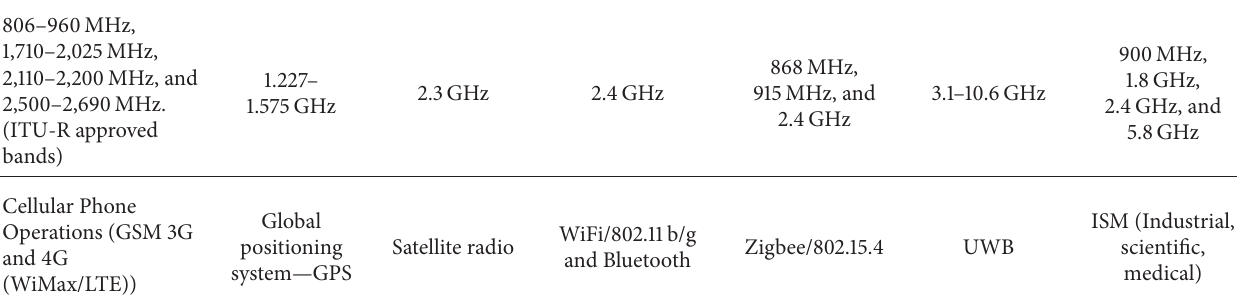
Table 1: Frequency bands of some of the popular wireless communication systems.